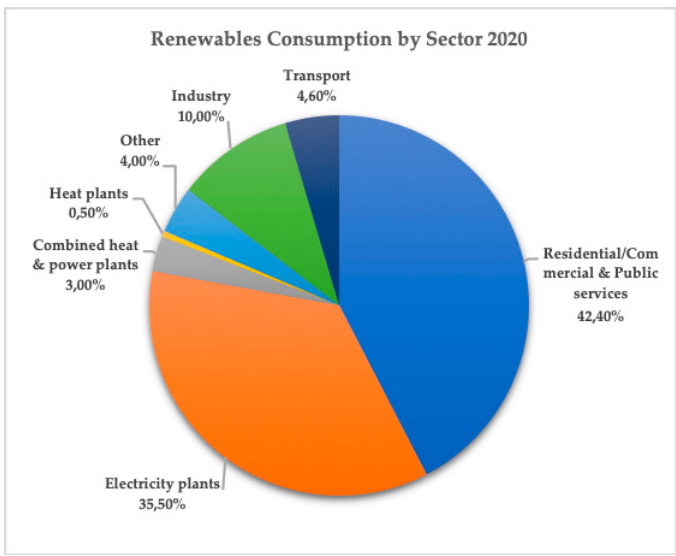
Figure 4. Renewables’ Consumption by Sector 2020 (authors’ forecasts).